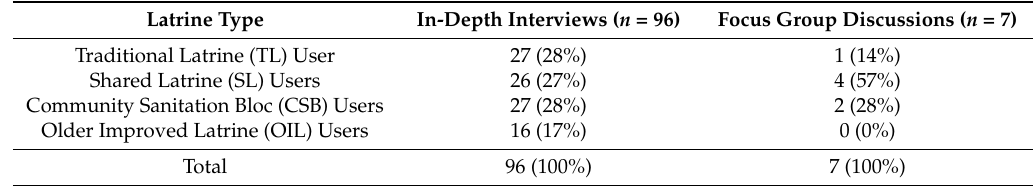
Table 1. Data collection